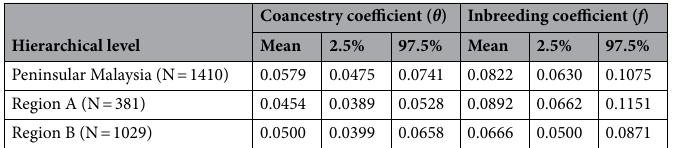
Table 3. Coancestry ( θ ) and inbreeding ( f ) coefficients for Shorea leprosula at each hierarchical level.